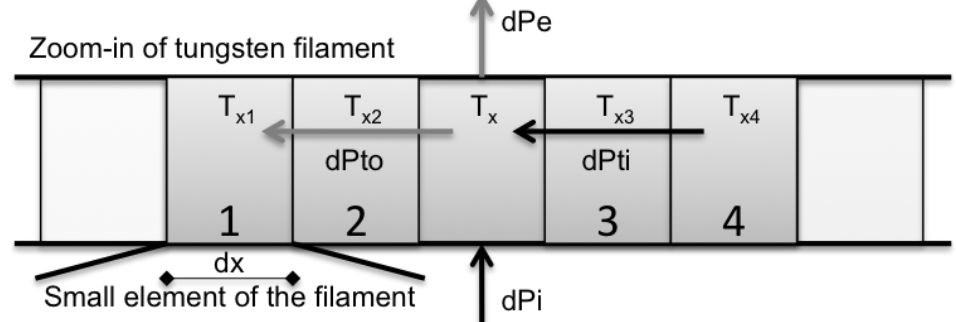
Figure A1. Power transport scheme for a small piece of the filament, the different pieces are numbered as they are used in Equations (A2)–(A9). The Black arrows indicate power into the filament piece, and the grey arrows indicate power out. dPti is the power piece 3 conducts from piece 4 into the center piece, and dPto is the power piece 2 that conducts from the center piece to piece